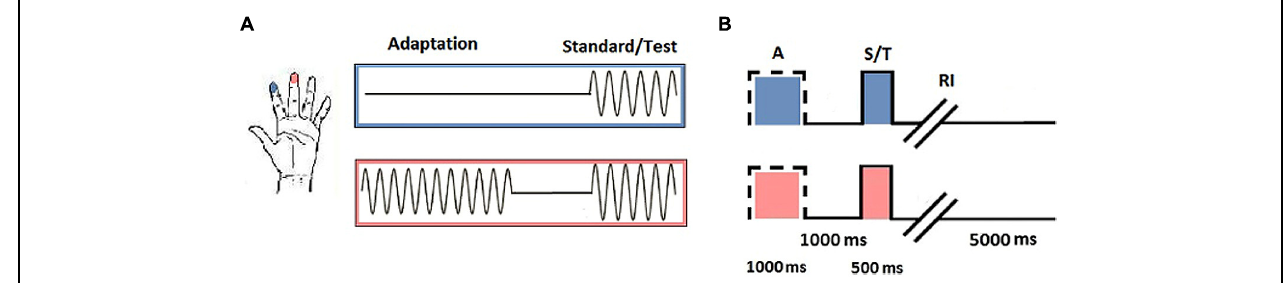
FIGURE 1 | Vibrotactile trials. (A) Trial stimulation: 25 Hz sinusoidal stimuli were delivered to D2 and D3 of the left hand. Adaptation trials consisted of a single pulse delivered to one digit (in this instance D3). During the test phase, stimuli were delivered simultaneously to D2 and D3. Subjects were required to determine which stimulus was of the highest amplitude. Baseline trials consisted only of the test phase. (B) Trial timing: Adaptation trials began with the presentation of a single pulse to the selected digit (A; 1000 ms), followed by an interval between the adaptor and test stimuli (1000 ms) before the standard and test stimuli were simultaneously delivered (S/T; 500 ms). Subjects were given an unrestricted response interval (RI) to indicate which digit they thought had received the stimulus of highest amplitude, after which an interval signaled the onset of the next trial (5000 ms; figure adapted from Tannan et al., 2007, with permission).